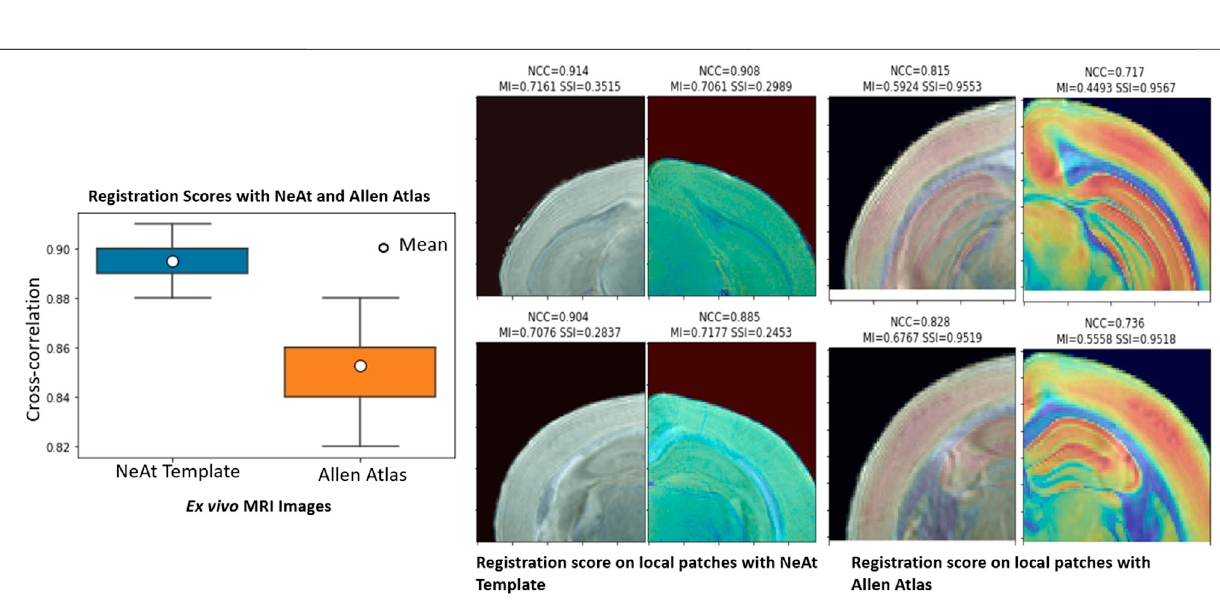
FIGURE 8 | Atlas/template selection: Left panel: Registration scores of brain image with the NeAt templates and the Allen atlas. The overall registration score with NeAt template is better. Right panel: Similarity scores calculated from randomly selected local patches of a registered image with both reference images. Cropped patches are overlayed with corresponding atlas used for